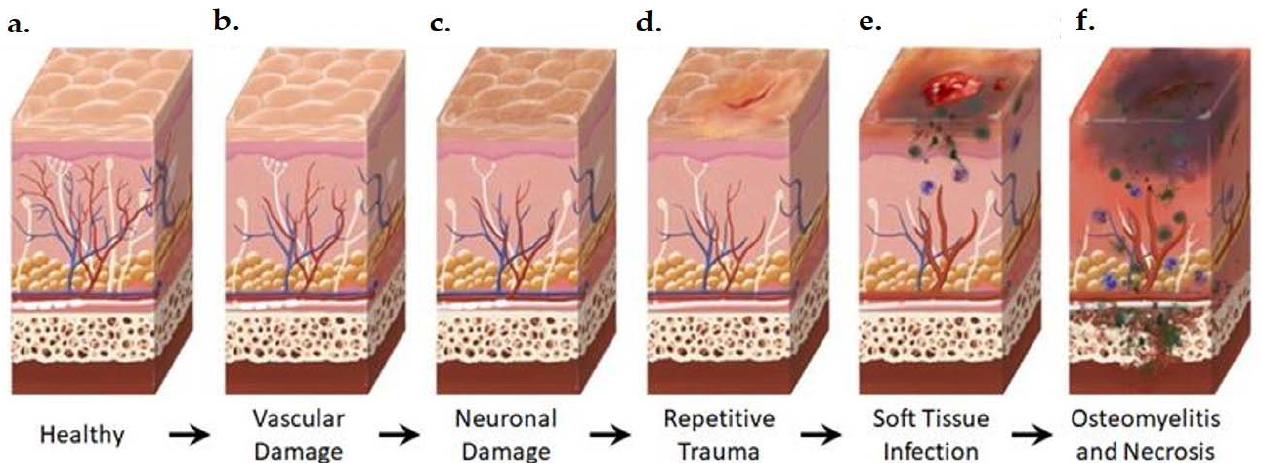
Figure 2. Anatomical Changes Associated with Diabetic Foot Pathophysiology. Diabetic neuropathy is a multi-faceted polyneuropathy related to an increased risk of ulceration, infection, and amputation. Sustained hyperglycemia damages the endothelial lining of the blood vessels in previously healthy tissue ( a ), leading to impaired circulation ( b ). Without sufficient vascular support, nerves die off and the skin may become dry and cracked as sweat secretions decrease ( c ). In the event of injury, numbness in the foot due to neuronal ischemia may mean that insults go undetected for some time ( d ). Fissures in the dried skin can harbor microorganisms, increasing the likelihood of wound infection. Initial microbial invasion of the trauma site leads to inflammation, vasodilation, and soft tissue necrosis ( e ). Decreased vascularization compromises immune response to infection and prolongs healing time. If the infection persists, usually because of delayed care or ineffective treatment, microbes may invade bone tissue, leading to osteomyelitis and bone deformation ( f ). White: neurons, red: arteries, blue: veins, purple: polymorphonuclear lymphocytes, green: microorganisms.